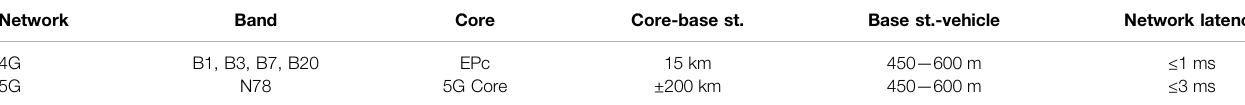
TABLE 1 | 4G and 5G network settings.